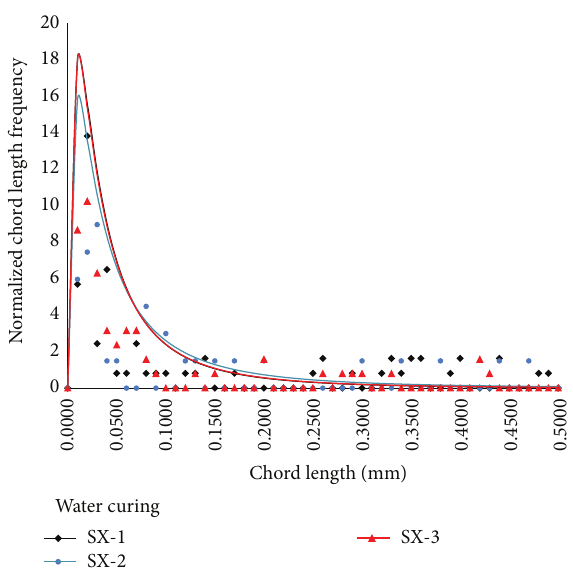
Figure 3: Bubbles normal distribution curves of samples under four times’ alternation of sodium sulfate erosion.